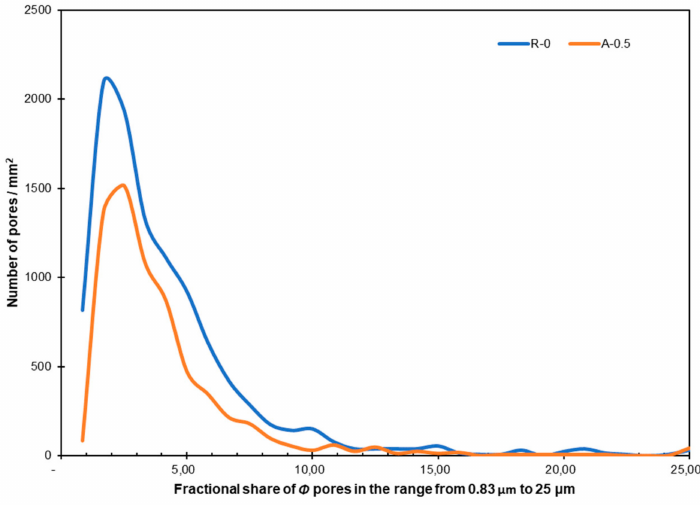
Figure 15. The fractional share of pores in the range of 0.83–25 µ m / mm 2 in the reference mortar and in the mortar with 0.5% of Al 2 O 3